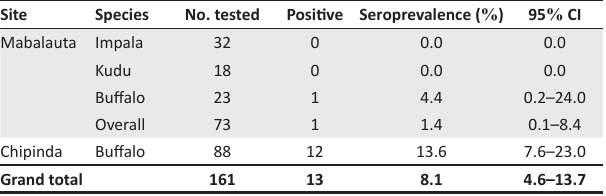
TABLE 2: Distribution of Rift Valley fever seroprevalence in wildlife according to site and species. Site Species No. tested Positive Seroprevalence ( % ) 95 % CI Mabalauta Impala 32 0 0.0 Kudu Grand total CI, confidence interval.